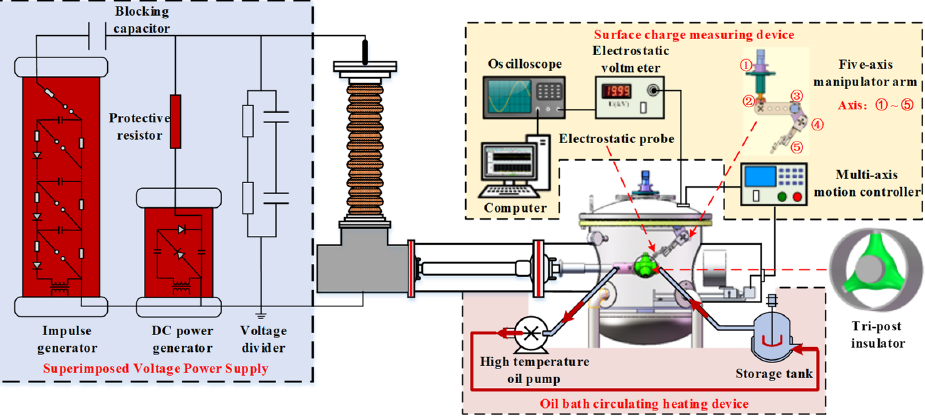
Figure 1. Experimental platform for charge accumulation and surface flashover of tri-post epoxy Figure insulators.